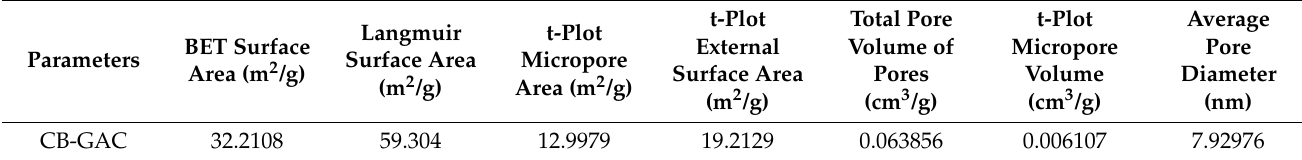
Figure 3. The characteristics of coal-based granular activated carbon (CB-GAC): ( a ) SEM image 1000×; ( b ) SEM image 5000×; ( c ) X-ray diffraction patterns; ( d ) N 2 adsorption desorption isotherm and pore size distribution. Table 4. Characteristics determined by Brunauer-Emmett-Teller (BET) method for composite samples.